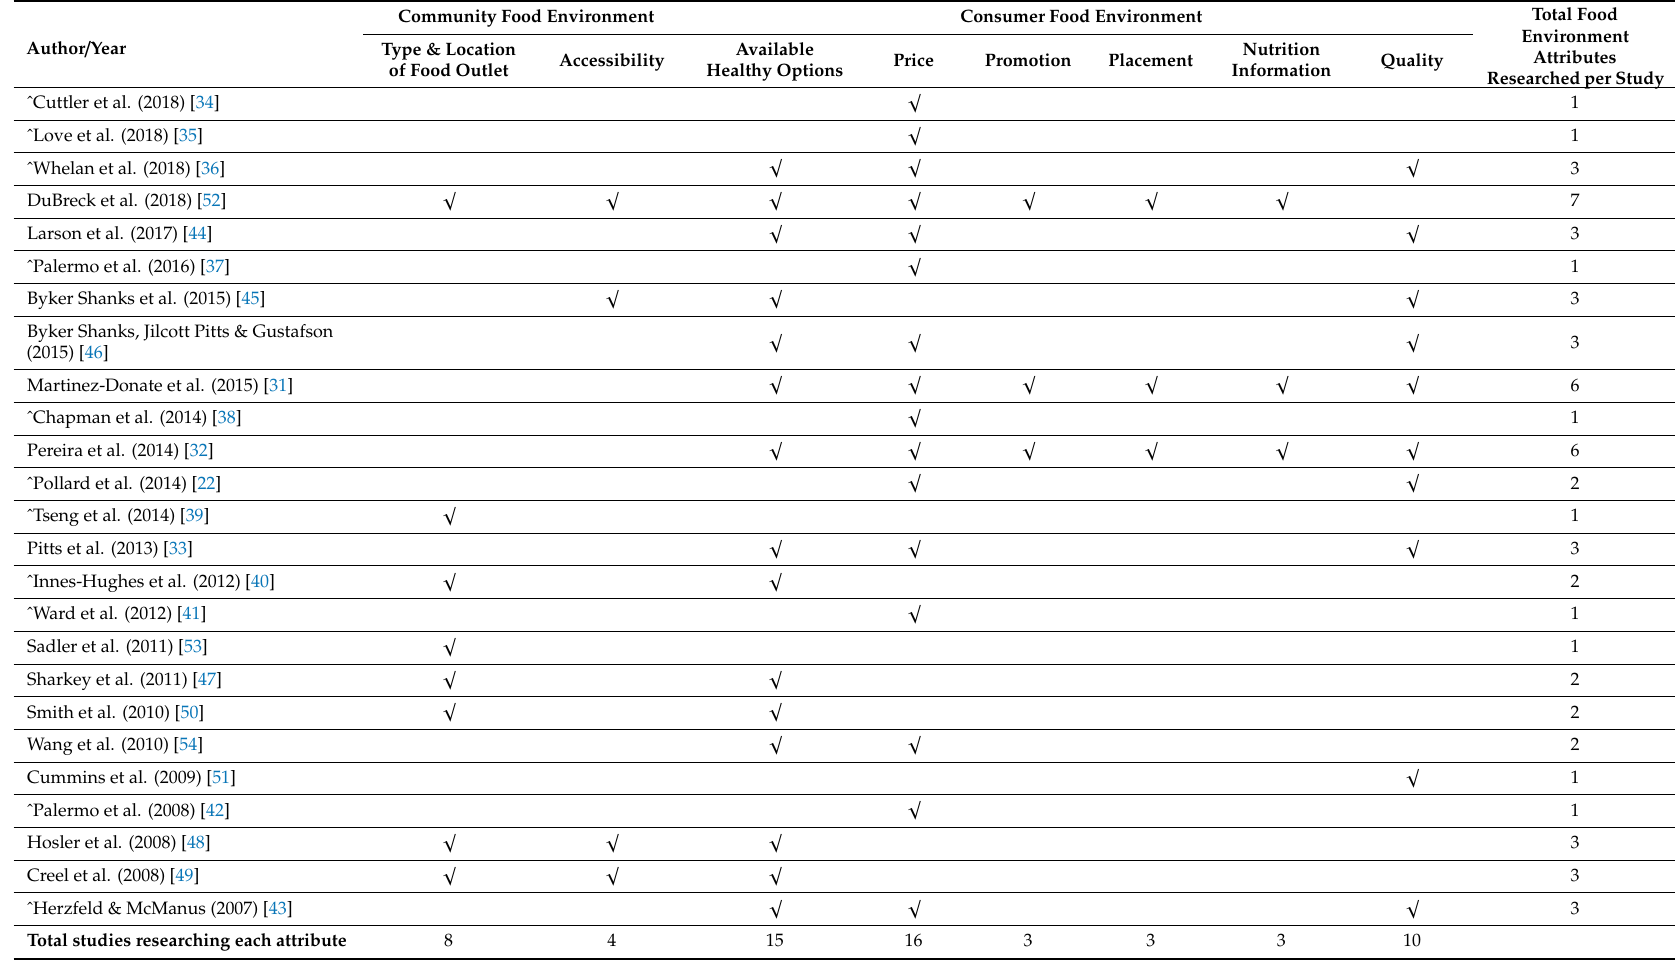
Table 2. Aspects of the Food Environment